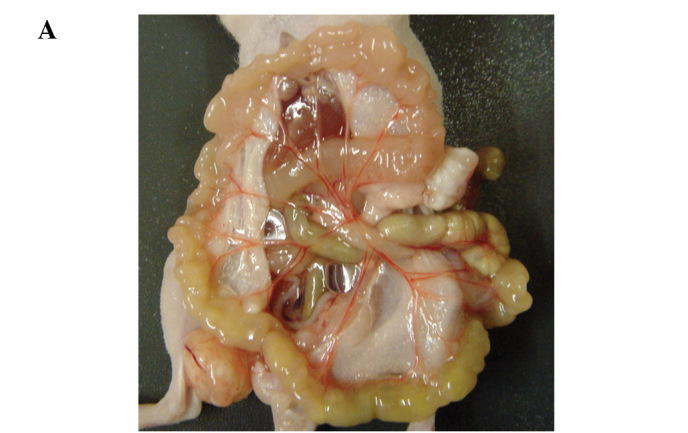
(A) Metastatic nodules derived from MKN45-SC and (B) MKN45-KD cells in nude mice. (C) Total number of metastatic nodules. (D) Total weight of metastatic nodules. (E) Necrosis in a dissemination nodule of nude mouse tissue derived from MKN45-KD cells. (F) Necrotic area of disseminated nodules. The MKN45-KD cells developed more disseminated nodules than did the MKN45-SC cells. Both types of KD cells (MKN45 and MKN74) showed a higher number of disseminated nodules and a heavier weight than the SC cells. The microscopic examination showed that the disseminated nodules derived from the KD cells had a larger necrotic area than that of the SC cells.